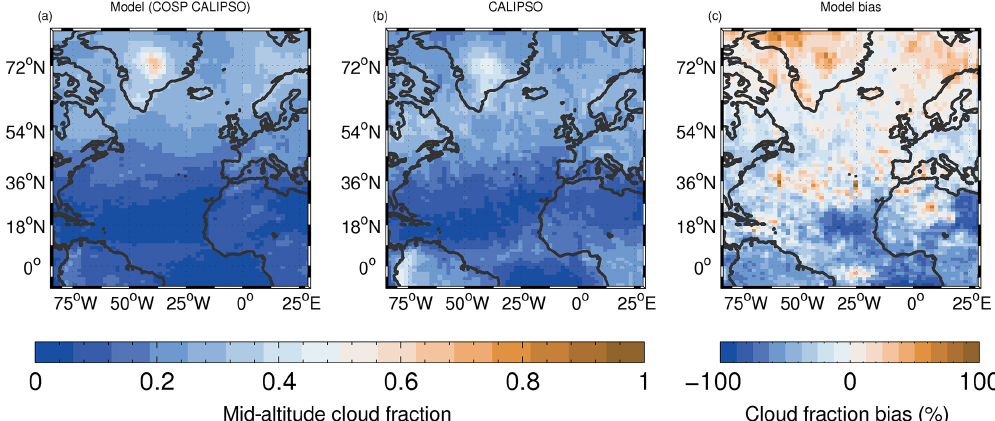
Figure 2. As for Fig. 1 except for mid-altitude clouds (440 ≤ CTP <